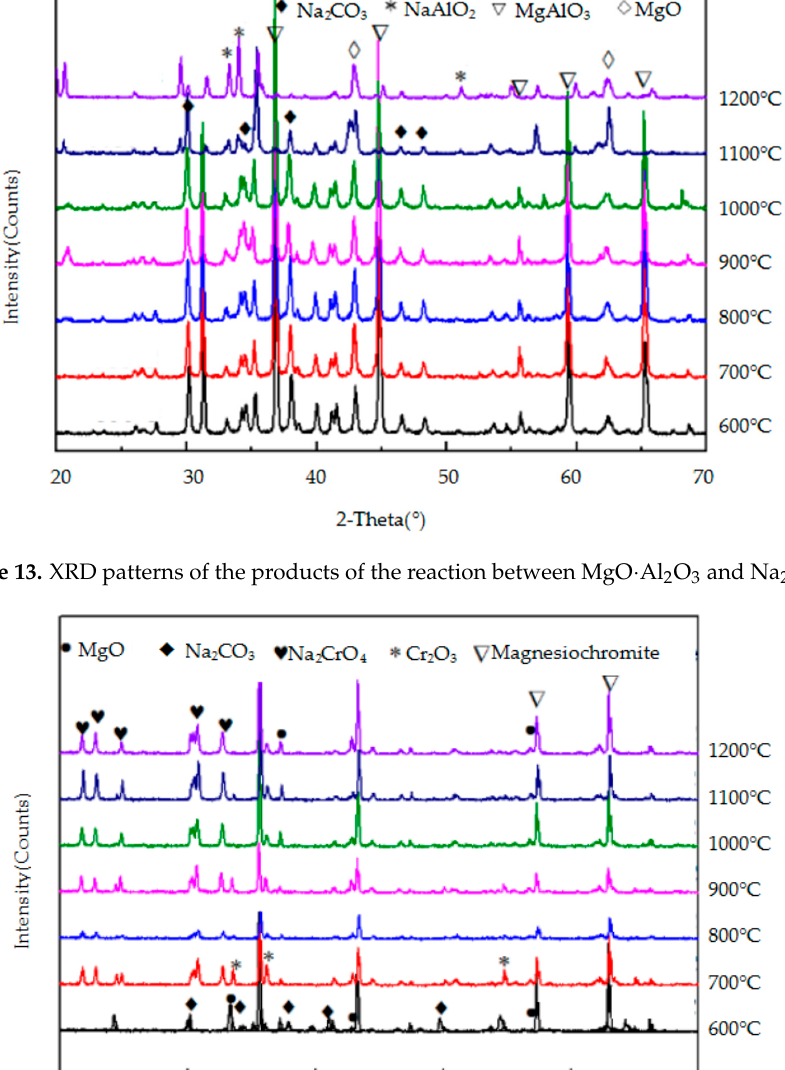
Figure 12. XRD patterns of the products of the reaction between MgO·Fe 2 O 3 and Na 2 CO 3 .